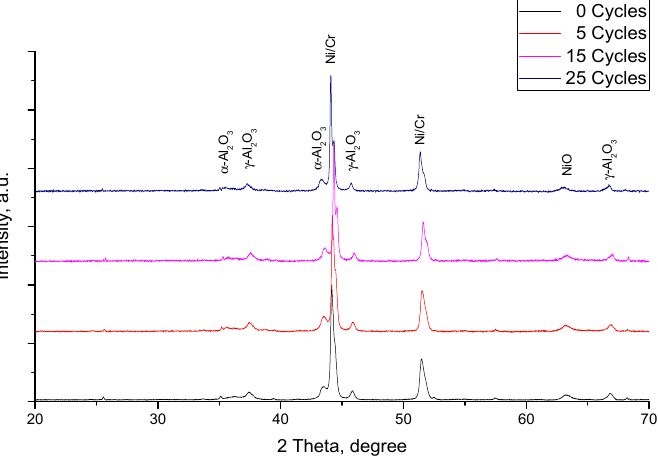
Figure 12. X-ray diffraction patterns of Al 2 O 3 -13 wt.% TiO 2 coating before and after heat treatment cycles.